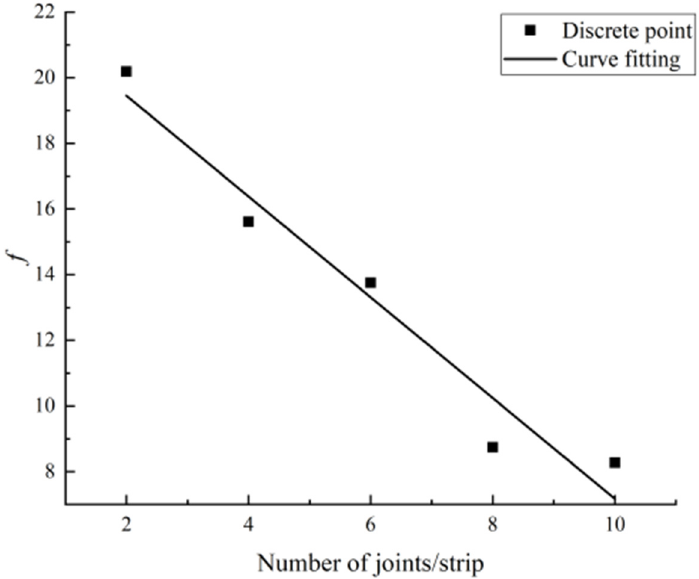
Figure 11. Fitting curve of parameter f .